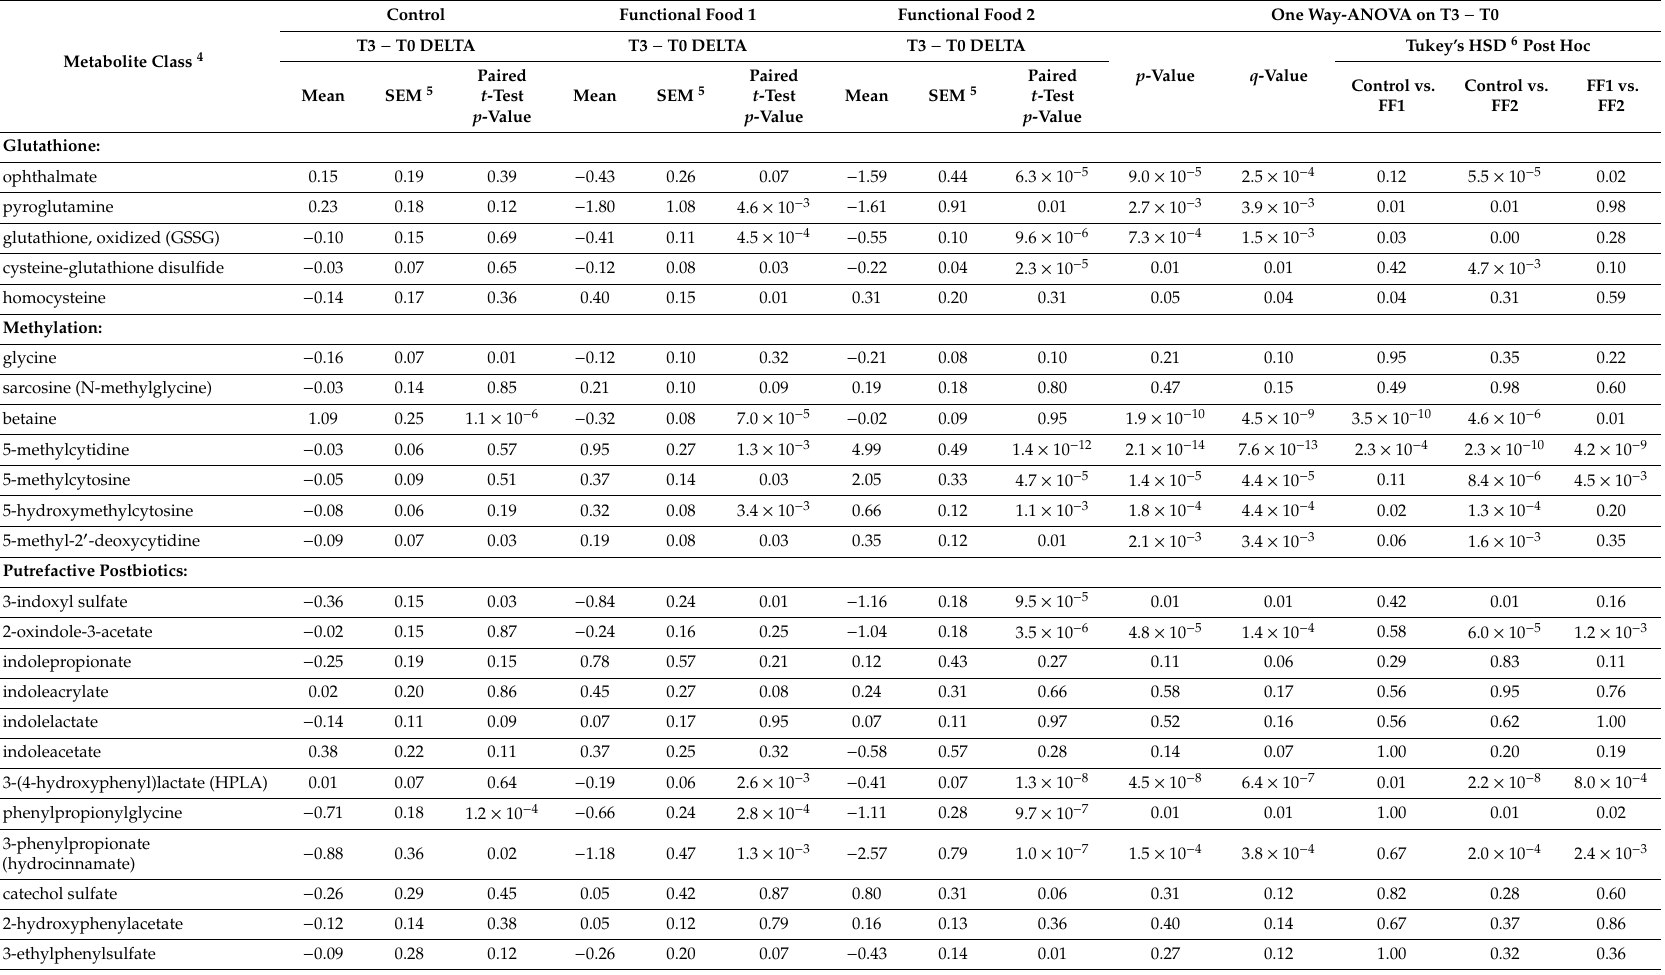
Table 6. E ff ect of feeding control 1 or one of two functional foods (FF1 and FF2) 2 on plasma concentrations of antioxidants, methylation substrates, and compounds produced by gut microbial metabolism in cats at baseline (T0) and after a three month (T3) feeding period 3 . Control Functional Food Metabolite Class 4